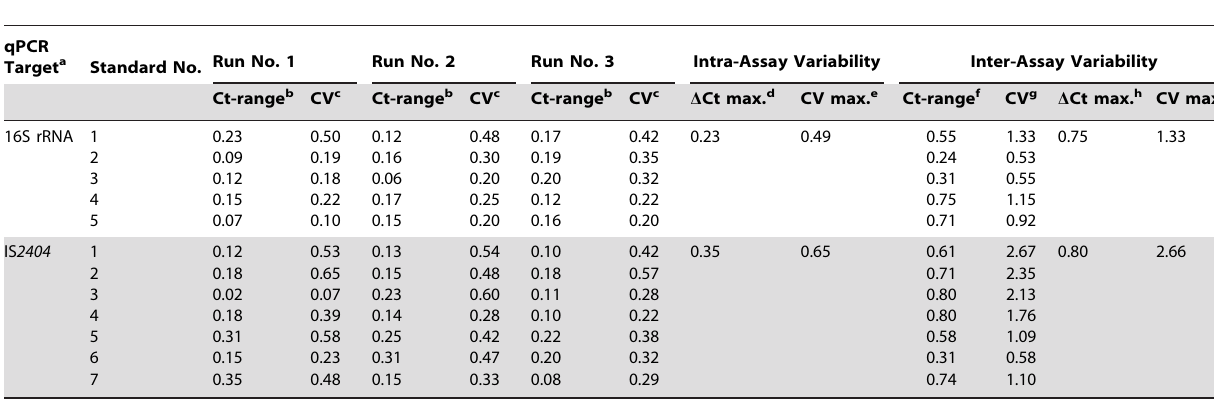
Table 5. Intra- and inter-assay variability of the 16S rRNA RT/IS 2404 qPCR assay.